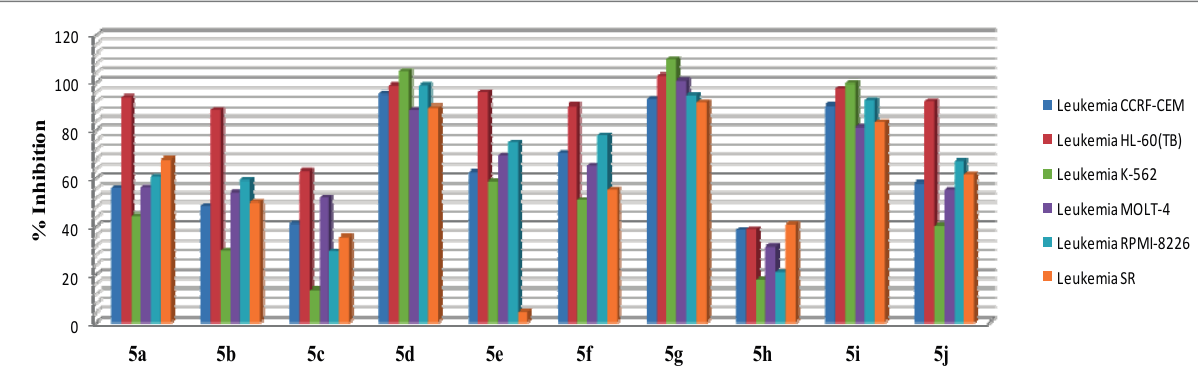
Figure 2. Inhibitory effects of the tested target compounds at 10 μ M concentration over all six tested leukemia cell